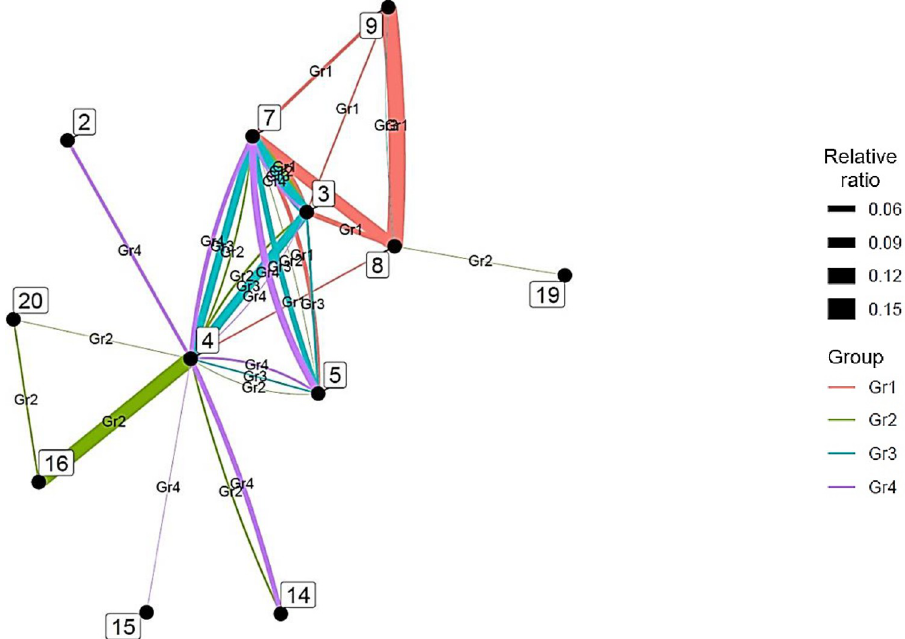
Fig 9. Distinctive interdisciplinary connections for each artificial intelligence